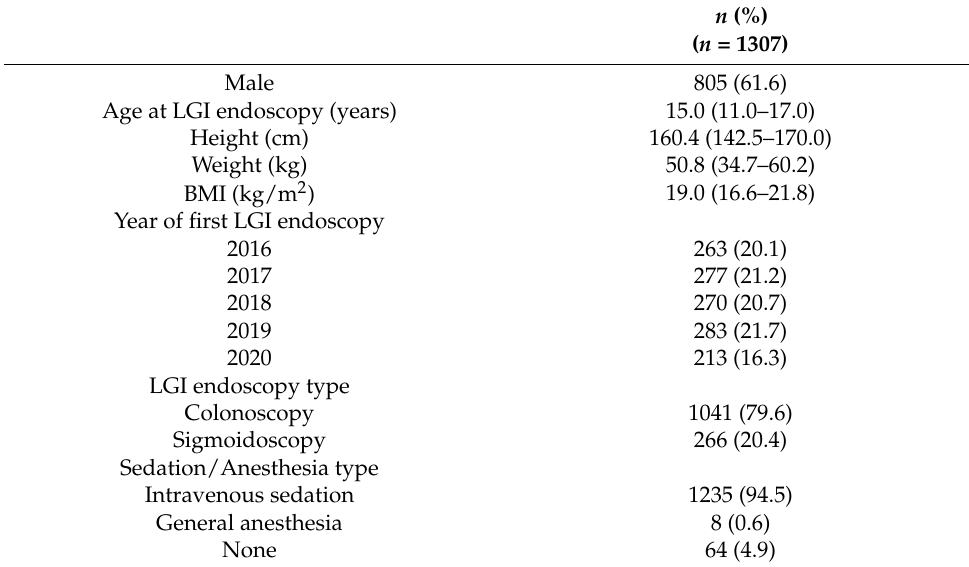
Table 1. Baseline